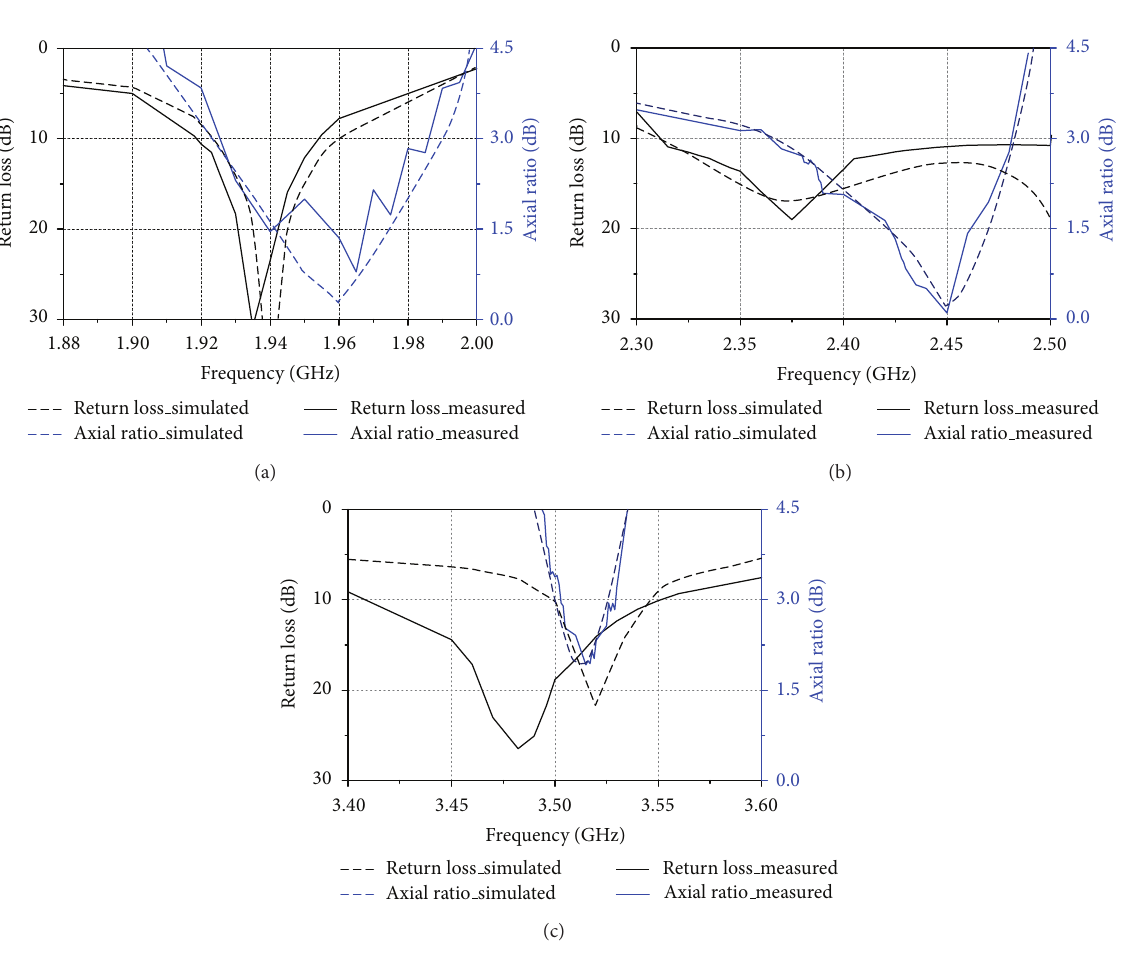
Figure 6: Simulated and measured return loss and AR of the proposed antenna. (a) Lower band, (b) middle band, and (c) upper band.